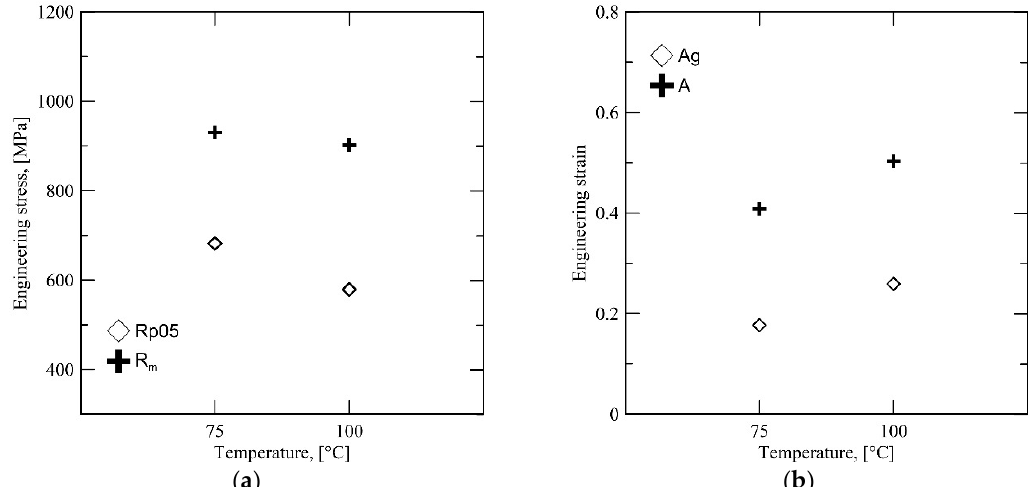
Figure 11. ( a ) R p05 and R m and ( b ) uniform and total elongations for Steel C with respect to initial quench temperature QT . Specimens annealed at 850 °C, quenched to QT and partitioned at 450 °C for 100 s.